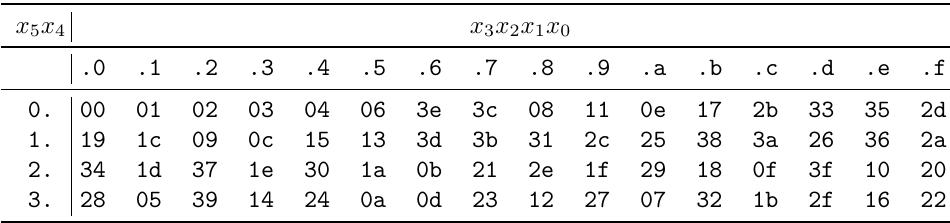
Table 1: The truth table for BipBipBox of the S-box layer. x 5 x